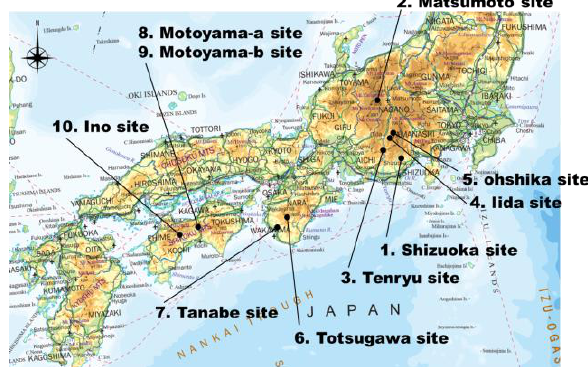
Figure 1. Location of field survey sites (on GSI Maps)